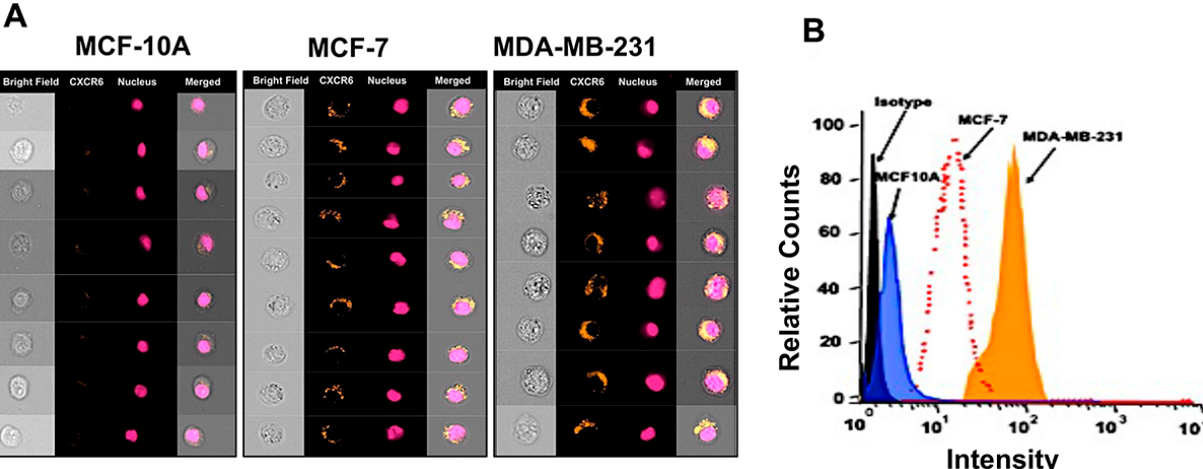
Figure 2. CXCR6 expression in breast cancer cell lines and normal epithelial cell lines. BrCa cells (MCF-7 and MDA-MB-231) and normal mammary epithelial cells (MCF-10A) were stained with PE-conjugated mouse anti-human CXCR6 or mouse IgG2a isotype control antibody. The images of stained cells (10 5 events) were acquired using an Image stream system. Panel ( A ) shows representative images of few cells. Panel ( B ) shows the analysis after spectral correction using Image Data Exploration and Analysis Software (Amnis, USA).